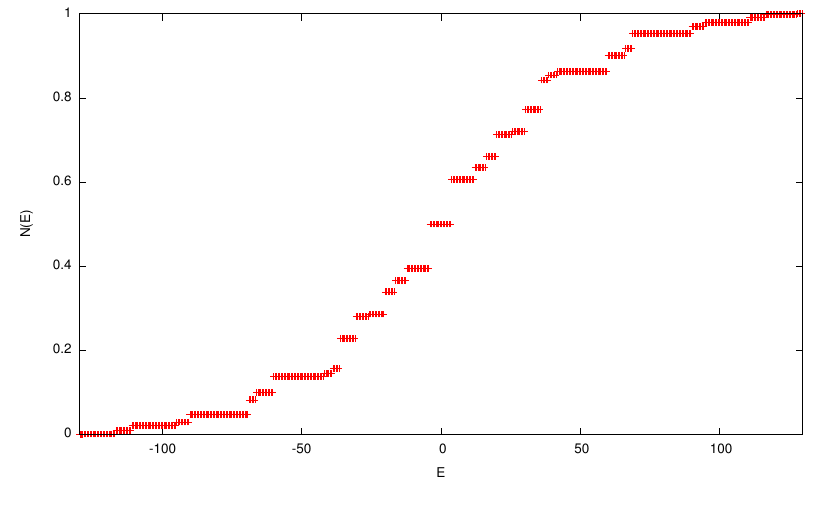
Figure 3 . The integrated density of states vs the energy